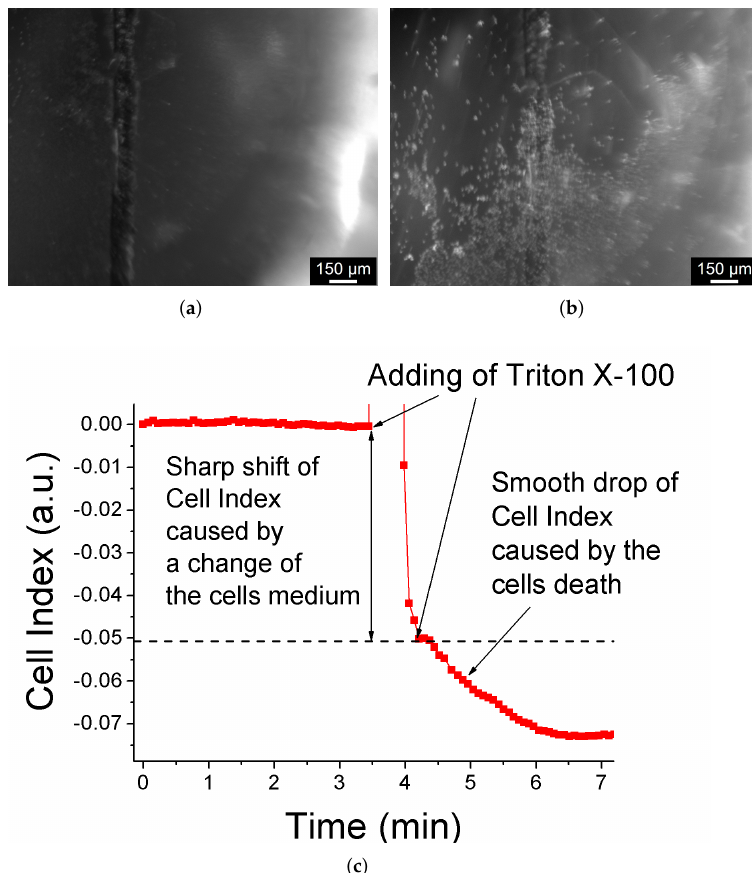
Figure 10. Estimation of the viability of the cells on the surface of the Cu–Ru electrode. Panels ( a , b ) correspond to fluorescence photographs (“N21” cube) of Cu–Ru electrode before and after Triton X-100 addition, respectively. It is clear that the cells were alive before the Triton X-100 addition since there is no fluorescence of propidium iodide. On the other hand, the cells became dead after Triton X-100 addition, which is confirmed by PI fluorescence (bright white dots). Panel ( c ) corresponds to the time evolution of the cell index. The obtained data indicate that before detergent was added when the majority of the cells on the electrode were alive, the cell index was stable at zero